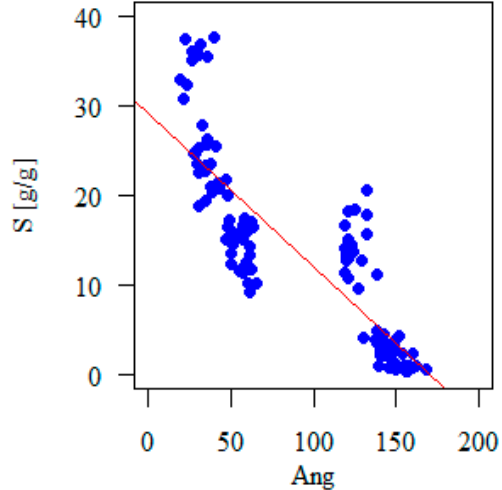
Figure 7. Dependency between canopy water storage capacity and contact angle; S, canopy water storage capacity; Ang, contact angle (°).